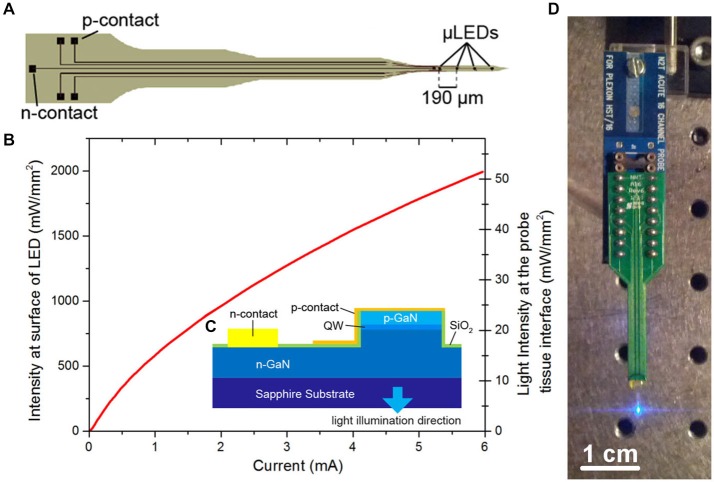
μLED probe. (A) Schematic of μLED probe, showing four μLEDs at the tip, the single n-contact and bonding pads linked with tracks to the p-contacts for each μLED. (B) Light output characteristics of one of the μLEDs on the neural probe at the surface of the μLED and at the tissue/probe interface. (C) Schematic cross section of the Sapphire-based probe (QW, quantum well). (D) Final device mounted onto a printed circuit board (PCB) and connected to a programmable current source.